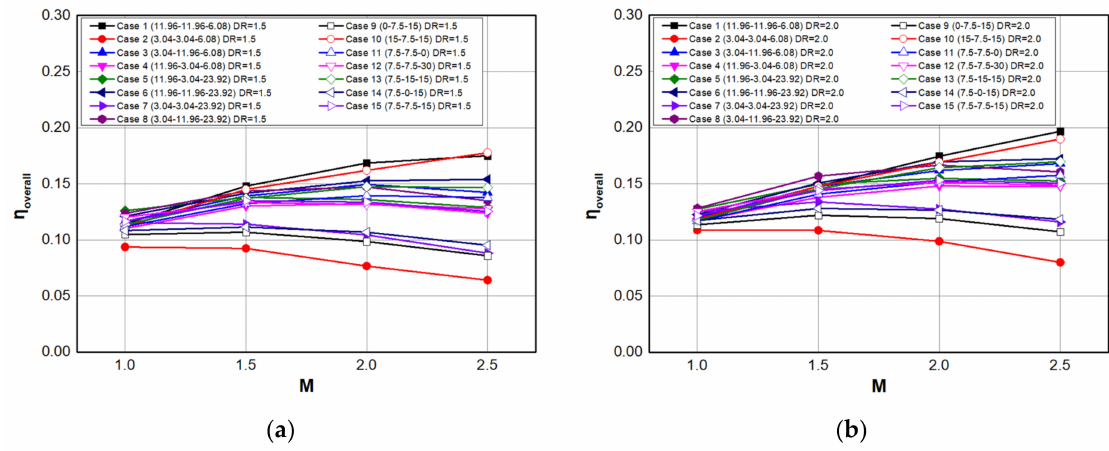
Figure 11. Overall averaged FCE for effect for all tested cases: ( a ) DR = 1.5, ( b ) DR = 2.0. Figure 12a indicates the overall averaged FCE versus the AR. Case 1 (11.96-11.96-6.08), Case 10 (15-7.5-15), and Case 6 (11.96-11.96-23.92) with relatively larger hole exit areas